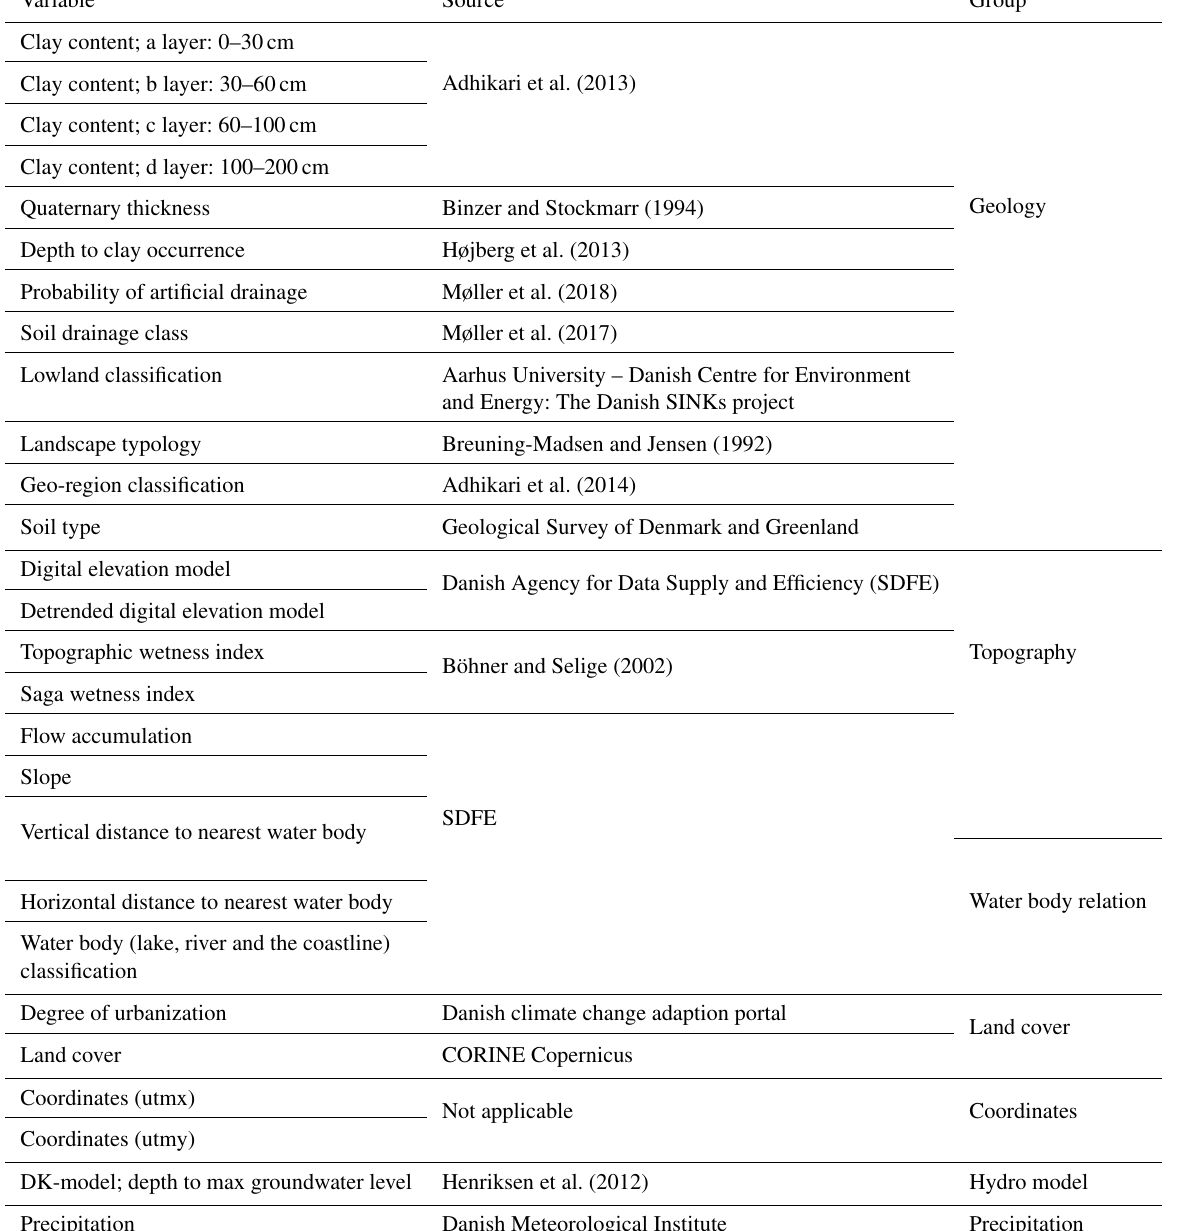
Table 1. Overview of the covariates used to model the shallow water table using RF. Variable